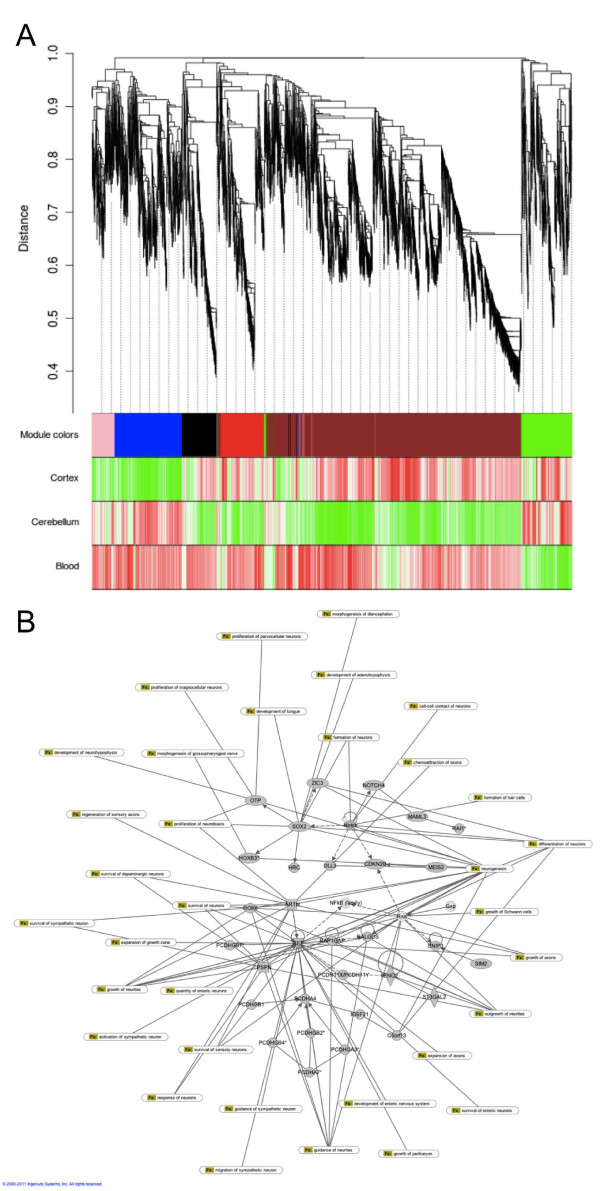
Weighted gene co-methylation network analysis of DNA methylation at intragenic CGIs. (a) Dendrograms produced by average linkage hierarchical clustering of intragenic CGIs on the basis of topological overlap. Modules of co-methylated loci were assigned colors as indicated by the horizontal bar beneath each dendrogram. The 'blue' module was strongly negatively co-methylated (r2 = -0.98, P = 4 × 10-5) in cortex. (b) IPA on the genes associated with the blue module highlighted a network involved in nervous system development and function.